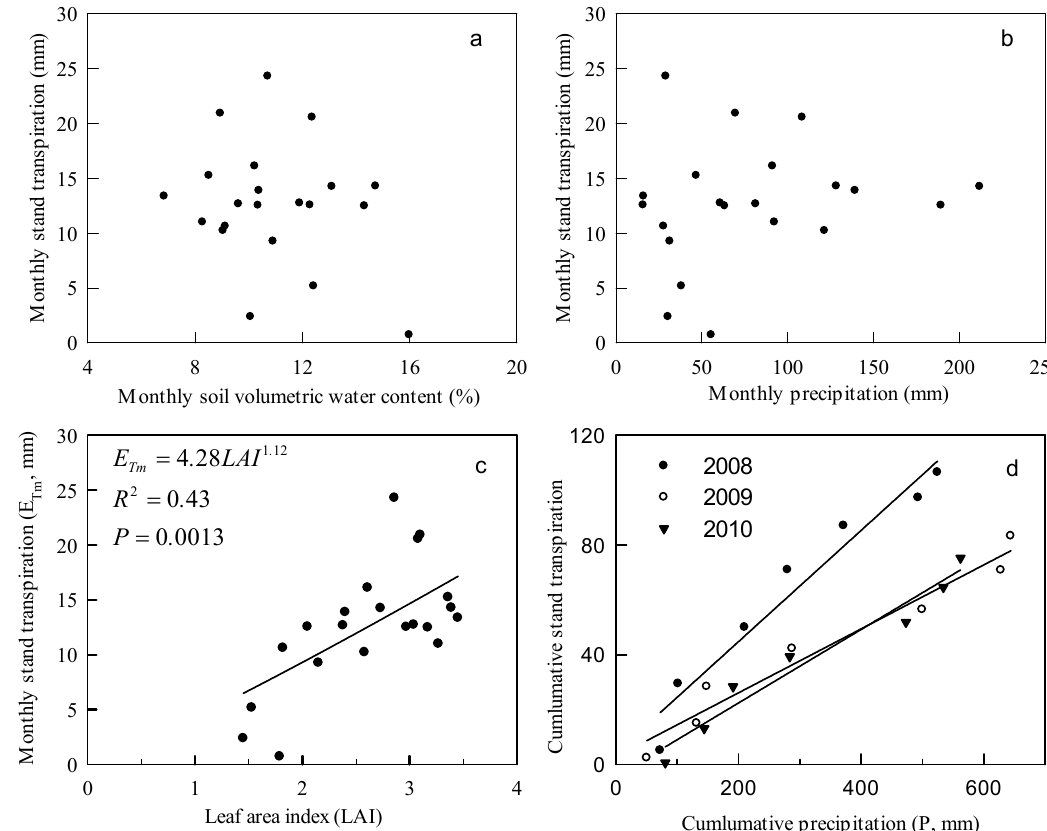
Figure 4. Relationships between monthly stand transpiration and monthly mean soil volumetric water content ( a ); monthly precipitation ( b ); and monthly leaf area index ( c ) in the growing seasons from 2008 to 2010; ( d ) the relationship between cumulative stand transpiration at monthly intervals through the growing season and corresponding cumulative precipitation within each year.